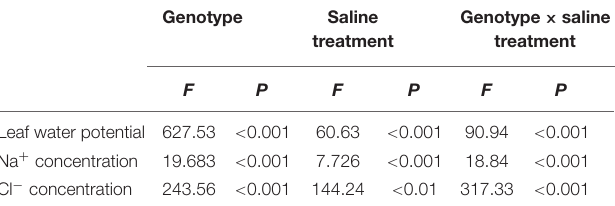
TABLE 6 | Two-way ANOVA examining the effects of genotype, saline treatment and their interaction (genotype × saline treatment) on the leaf water potential, Na + and Cl − concentrations of leaves from the three P. amurensis sample